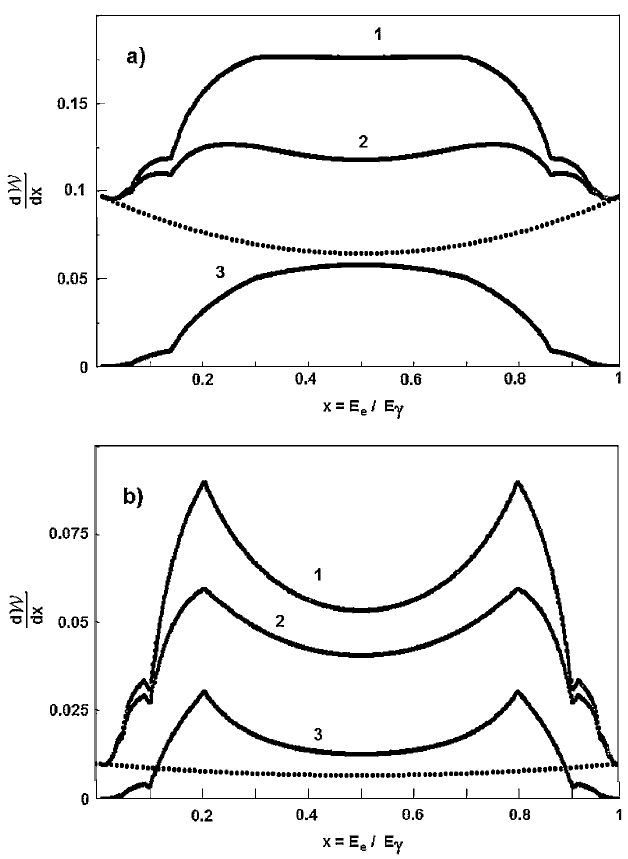
FIG. 2. Production of e (cid:2) pairs by a high energy photon mov- ing in a bent single crystal. ( xyz ) is the local Cartesian coordinate system. The y axis is directed perpendicularly to the plane of the figure; d is the interplanar distance, (cid:4) 0 is the entrance angle, and (cid:4) is the variable angle relative to the (110) plane of the single crystal.